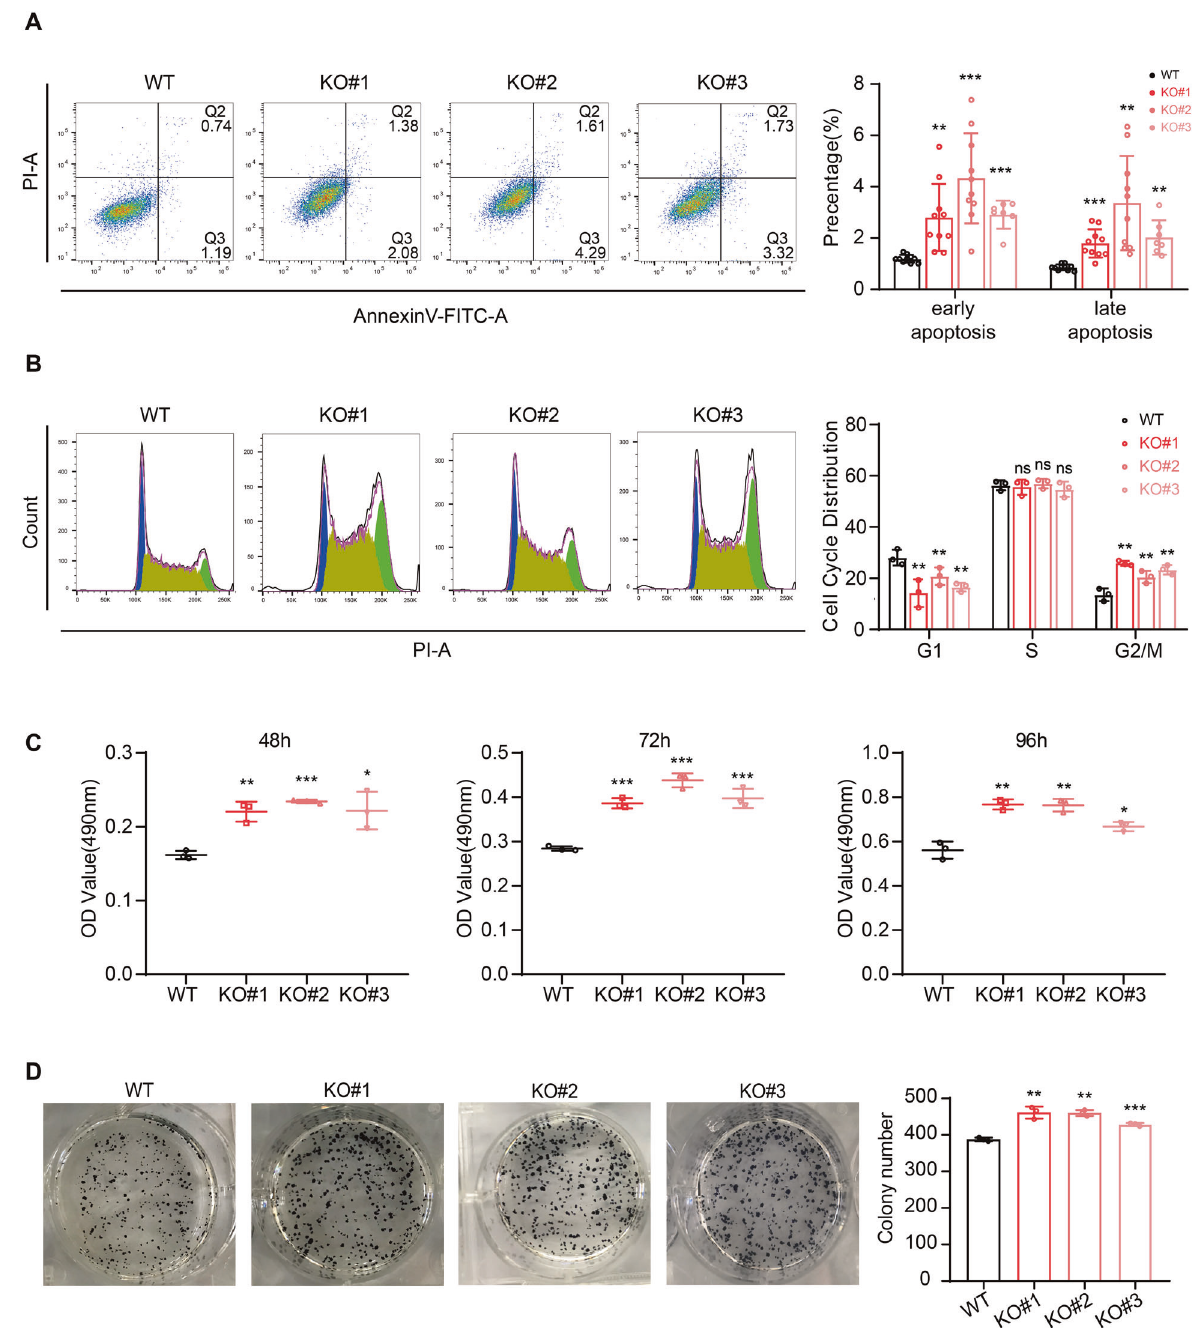
Fig. 2 CHD8 depletion alters the apoptosis, cell cycle, and proliferation process in human ESCs. A Apoptosis assay with PI and AnnexinV double staining detected by FACS. The results were calculated and compared with WT ESCs ( n = 7). B Cell cycle analysis using PI staining in WT and CHD8-KO ESCs. The populations of different phases were calculated in FlowJo (v10.4.0) ( n = 3). C The OD490 value for MTT assay in three time points during culture ( n = 3). D Colony-forming analysis visualized by AP staining and the statistics of the colonies number was shown in bar graph ( n = 3). The error bars represented the mean ± SD and the signi fi cance level was calculated by Student ’ s t -test (two-tailed, equal variance) (ns means not statistically signi fi cant, * P < 0.05, ** P < 0.01, *** P < represented the terms of cell proliferation and apoptosis (Fig. 7C). We further examined the protein levels of some key apoptosis-related genes and found cleaved PARP1 (cPARP1), ROCK1 and P53 maintained the higher levels in CHD8 knockout NPCs (Fig. 7D). Altogether, these results suggested that loss of CHD8 leads to apoptosis-related genes extremely active during neuroectoderm differentiation.